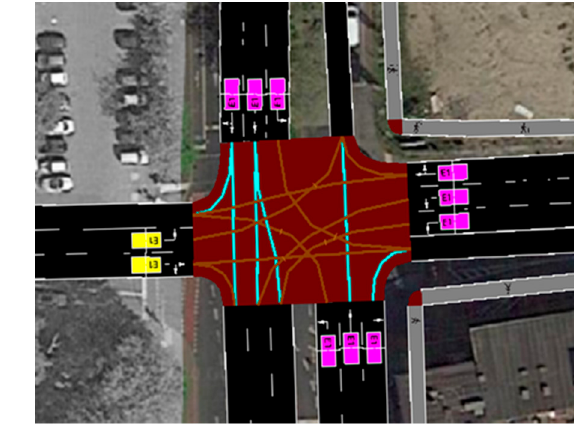
Figure 4. Position of detectors of an intersection. ( a ) on map, ( b ) in SUMO.